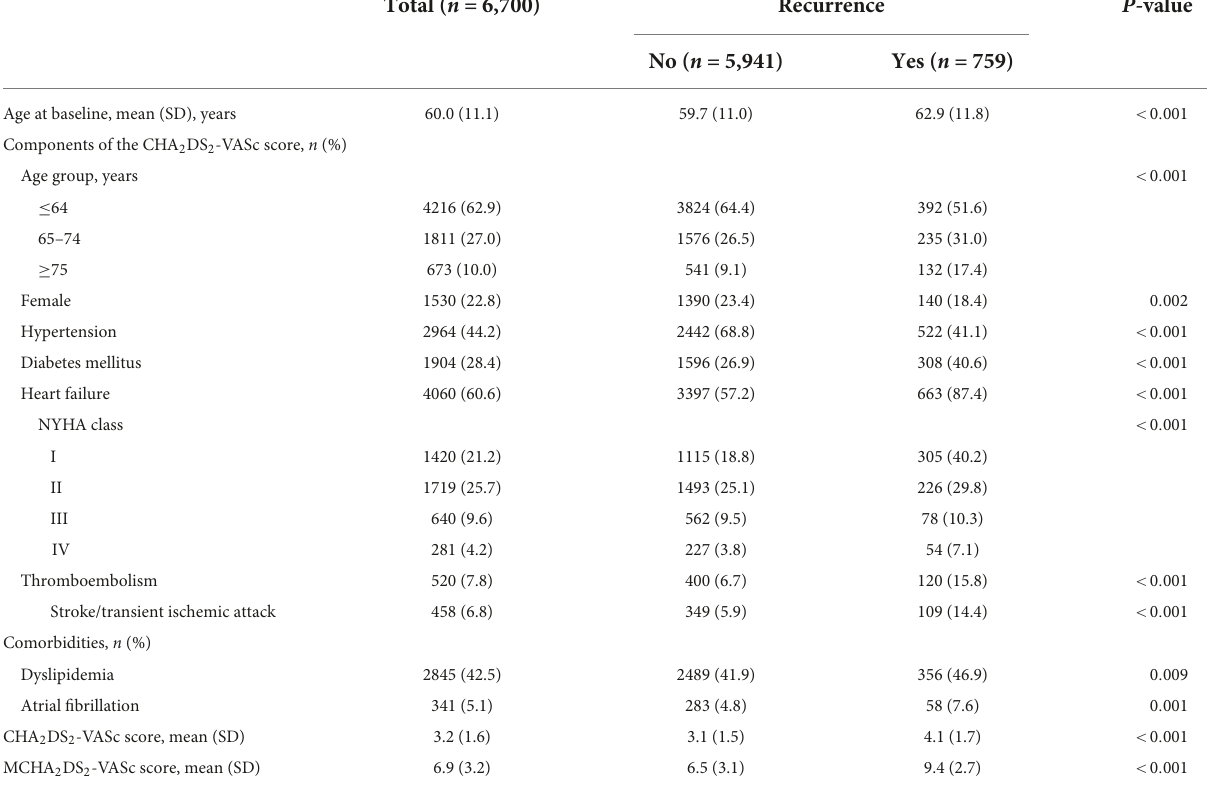
TABLE 1 Baseline characteristics of myocardial infarction patients with or without recurrence.